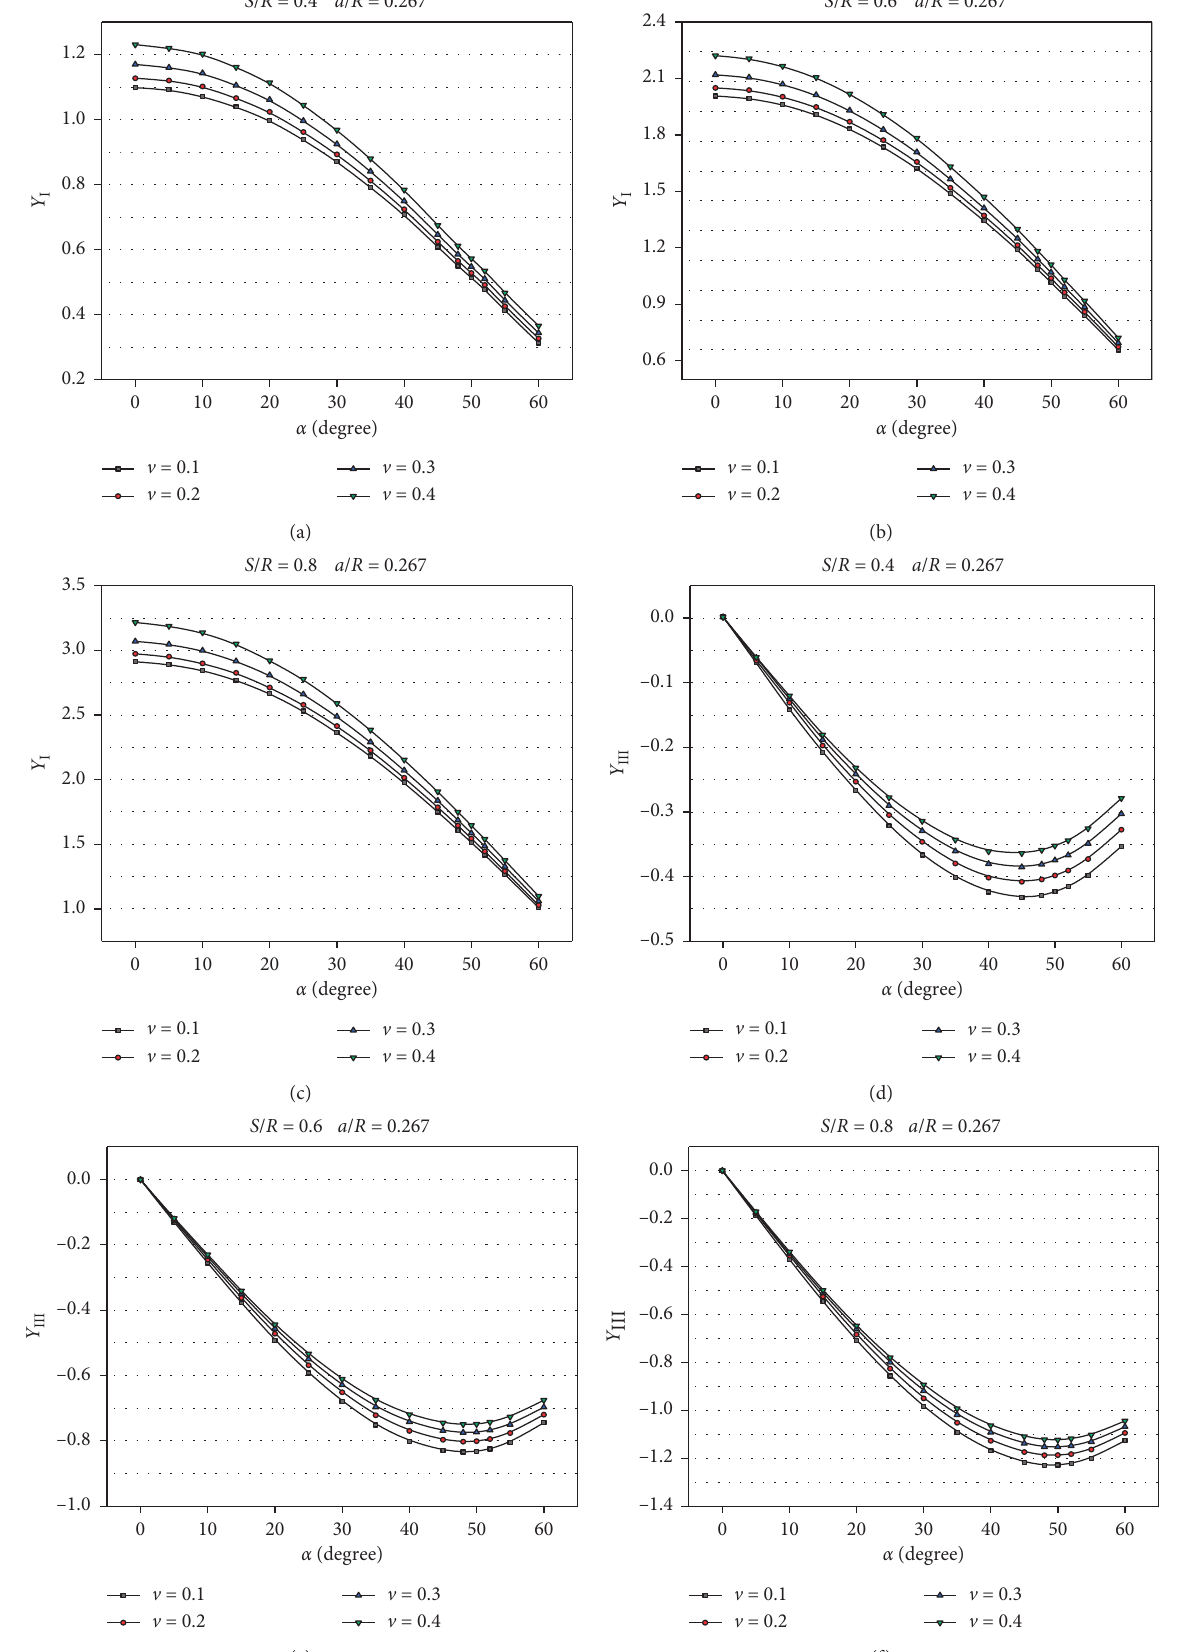
Figure 5: Variations of Y I and Y III with α for different S / R and